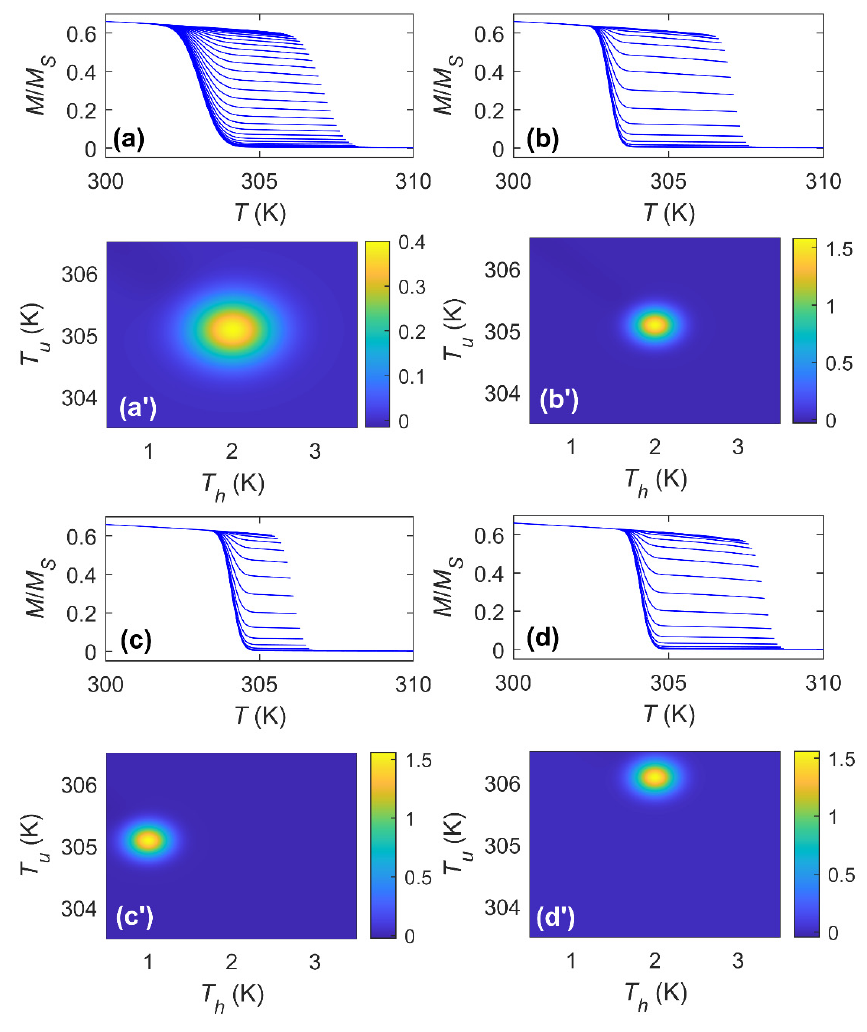
Figure 3. Cooling first order reversal magnetization curves and associated Temperature First Order Reversal Curve (TFORC) distributions with different transformation characteristics: ( a )–( a’ ) (cid:2022) (cid:3009) =